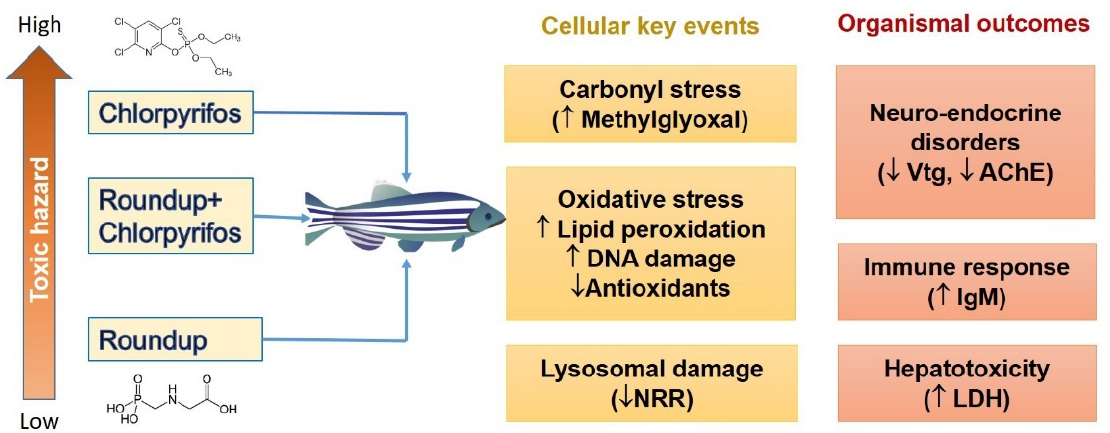
Figure 1. Cellular key events and organismic adverse outcomes in zebrafish ( Danio rerio ) from the effects of organophosphate pesticides (Roundup and chlorpyrifos) (Reprinted with permission from [19]. 2022, Elsevier) .